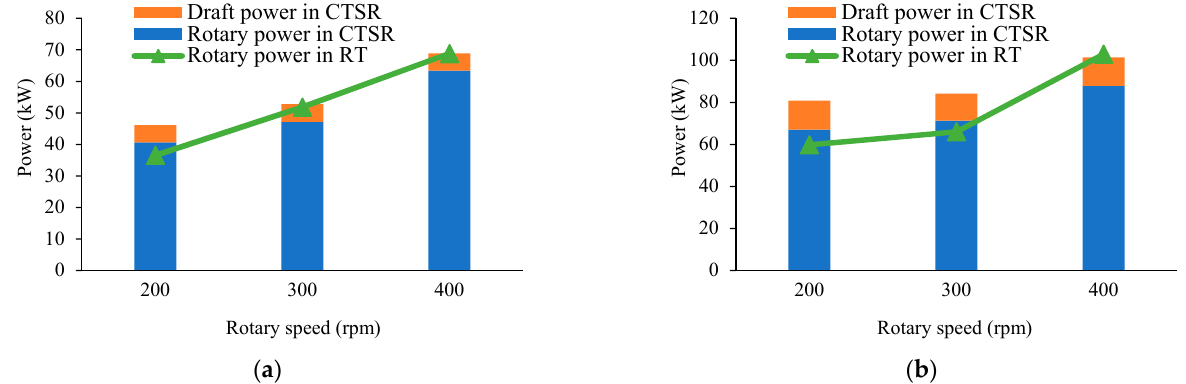
Figure 7. The effect of the forward speed and rotational speed on power: ( a ) forward speed = 0.43 m/s and ( b ) forward speed = 0.84 m/s.